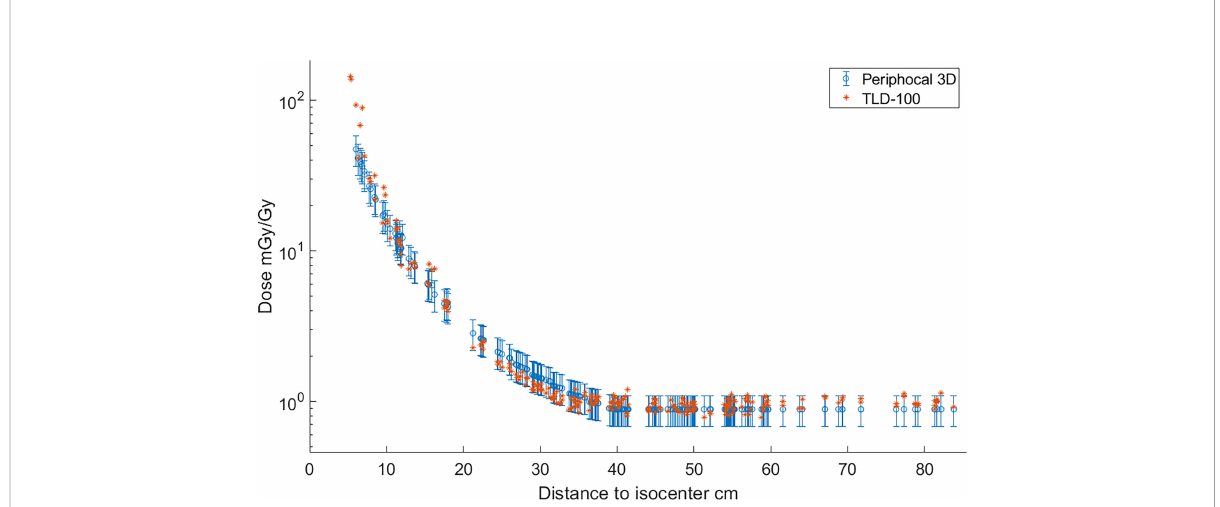
FIGURE 4 Absorbed dose, expressed as peripheral dose (mGy), calculated by Periphocal 3D and measured with TLD-100, relative to the isocentric dose (Gy) for a VMAT irradiation of the prostate. As TLDs positions are scattered inside the ATOM phantom, the dose values were plotted versus Euclidean distance to the isocenter. TLDs uncertainties are within the size of the